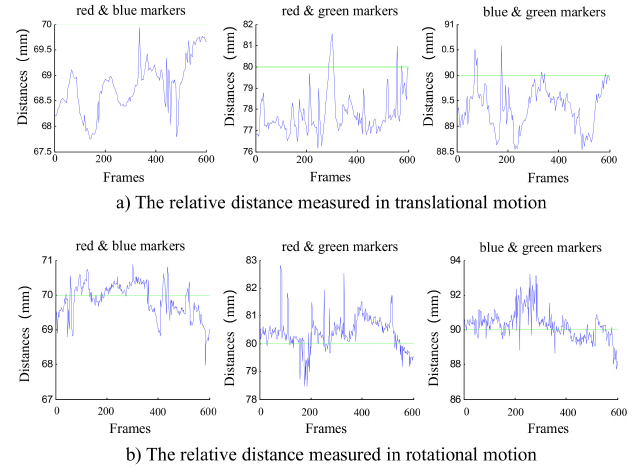
Figure 24. The system errors analysis of the relative distances of calibrated